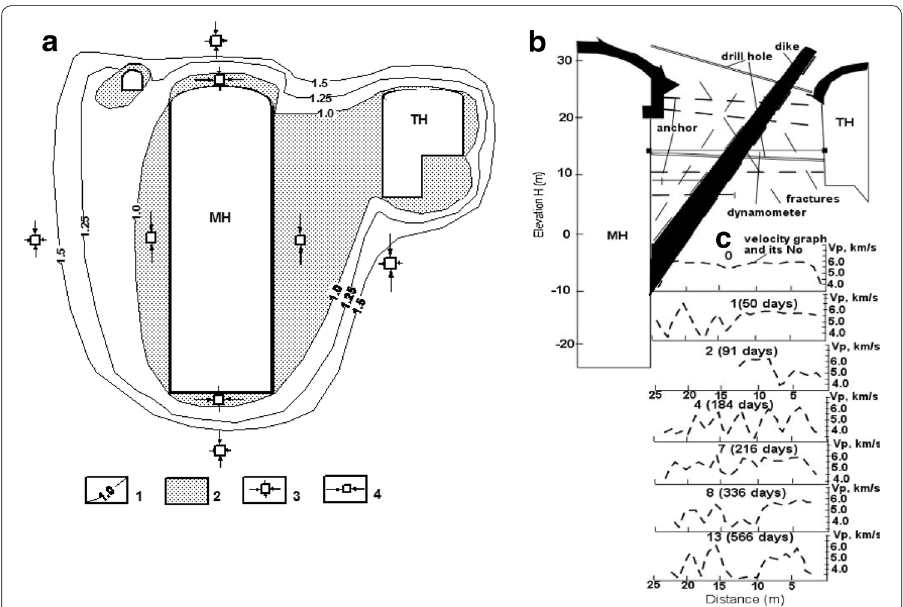
Fig. 11 a Calculated stress field around machine (MH) and transformer (TH) halls at σ 3 /σ 1 engineering-geological cross-section and observation scheme in the MH section ( c ) and velocity graphs along drill hole between MH and TH by observation cycles (time in days is denoted in brackets). 1 iso-lines of the strength reserve coefficient θ (by O. Mohr); 2 ultimate deformation (fracturing) zone θ < 1.0; 3 stress-state mode; 4